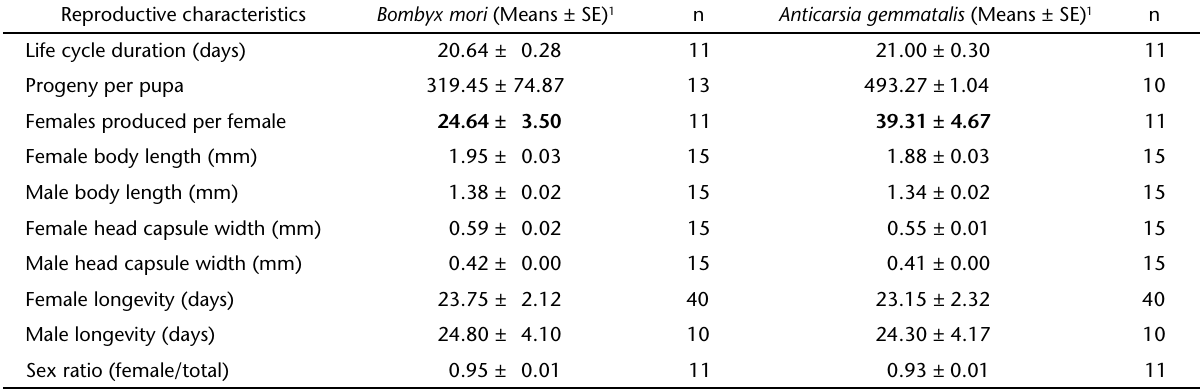
Table II. Reproductive characteristics (mean ± standard error) of P. elaeisis when reared on pupae of T. arnobia after six generations on pupae of B. mori or A. gemmatalis